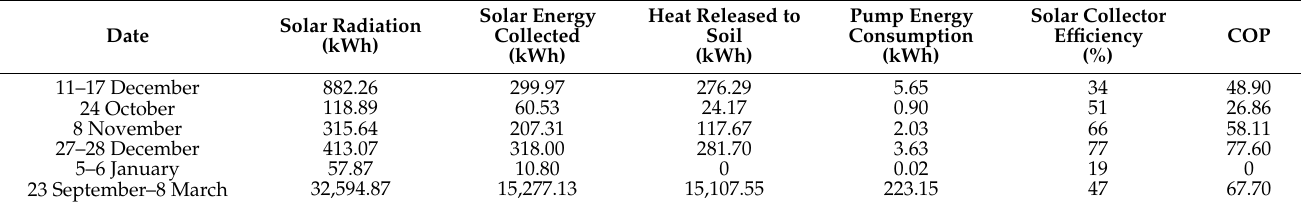
Table 4. Performance indexes on typical days.